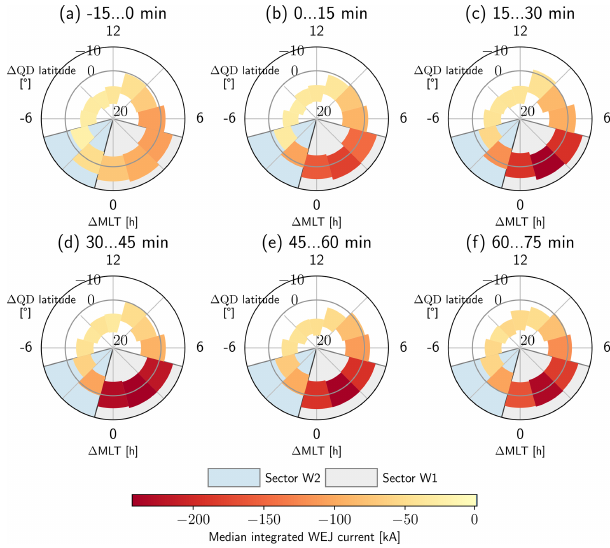
Figure 10. The MLT and (cid:49) QD latitude locations of the WEJ peaks as well as the poleward and equatorward borders in the 2h MLT bin centred around the onset location 0 to 15min after the onset. (cid:49) QD is the latitude relative to the onset latitude.